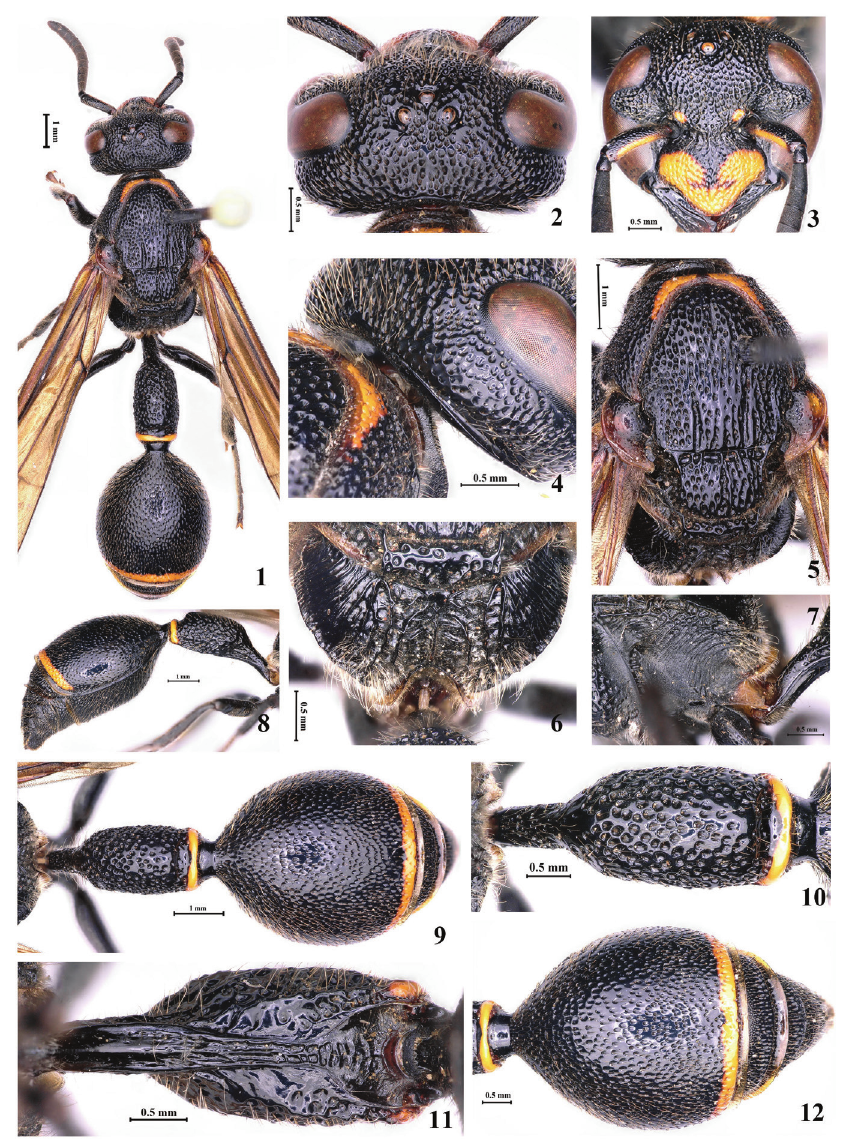
Figures 1–12. Zethus striatus sp. nov., holotype 1 habitus in dorsal view, ♀ 2 vertex, ♀ 3 head in frontal view, ♀ 4 vertex in dorsal-lateral view, ♀ 5 mesosoma, ♀ 6 propodeum in dorsal view, ♀ 7 propodeum in lateral view, ♀ 8 metasoma in lateral view, ♀ 9 metasoma in dorsal view, ♀ 10 T1, ♀ 11 S1, ♀ 12 T2, ♀ . striae and lateral carina, its dorsolateral surface with distinct and oblique striae and strong longitudinal carina along submedian carina, posterior surface of propodeum with transverse striae along median carina, submarginal carina produced into lamella above propodeal valvulae, its lateral surface with punctures along lateral carina and weak striae on its lower half (Fig. 7); orifice more or less angled dorsally (Fig.